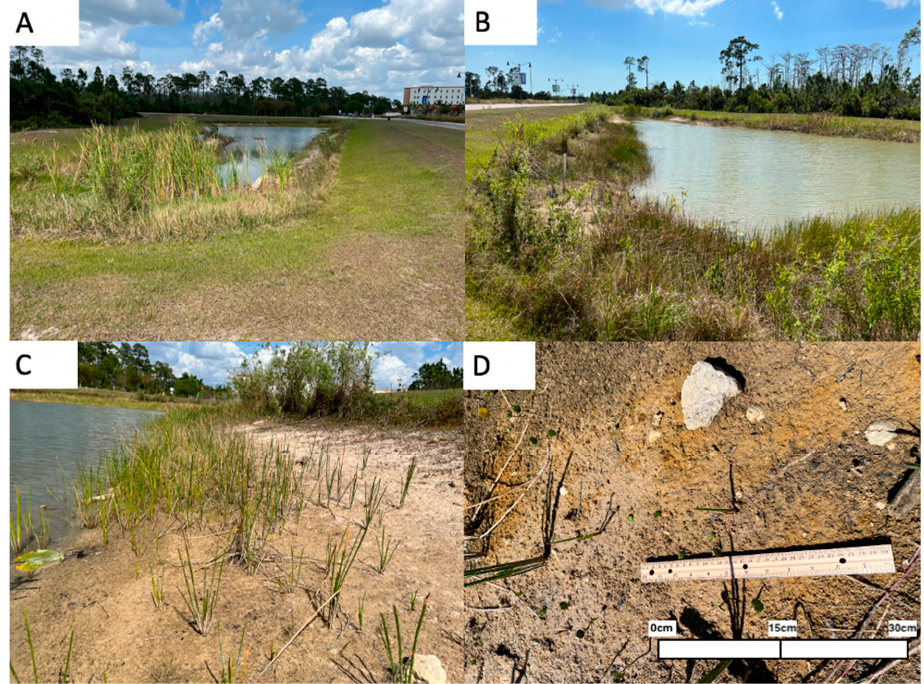
Figure 2. Pictures of the SOVI Pond taken during the dry season: ( A ) view of the lake facing north showing vegetative growth near inlets and control structures. ( B ) View of the pond facing south showing areas of heavily and poorly vegetated shoreline. ( C ) View of the shoreline facing north showing the natural soil and colonizing spikerush ( Eleocharis cellulosa ). ( D ) Close-up view of the soil showing young spikerush shoots.